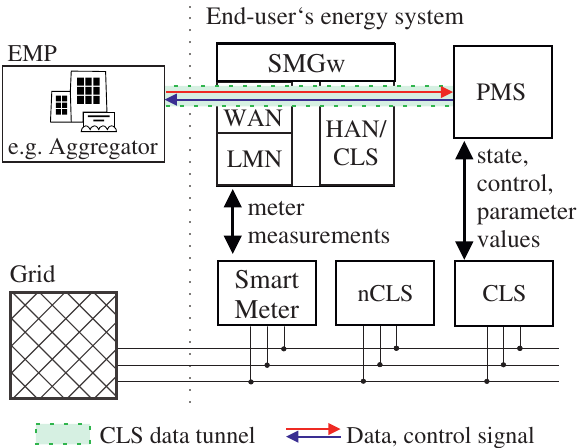
Figure 4. Proposed implementation of flexibility communication and control into Smart Meter Gateway (SMGw) infrastructure, following the regulations from [32]. The external market participant (EMP) receives flexibility information through the transparent data tunnel functionality of the SMGw, connecting the wide area network (WAN) and the controllable local systems (CLSs). The power management system (PMS) adjust the CLS schedule, following EMP